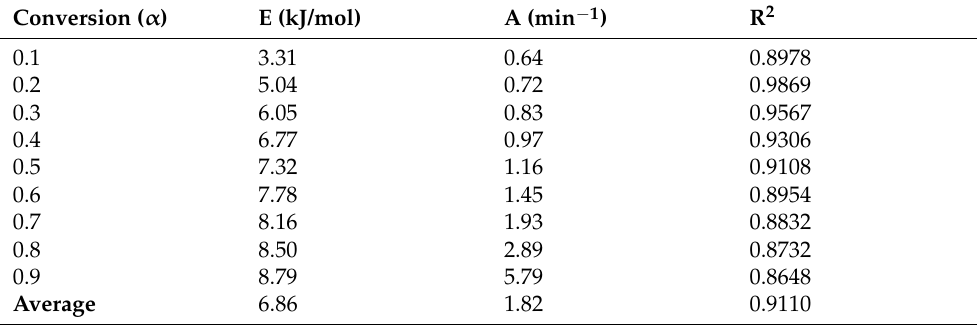
Figure 6. Linear plots of Coats-Redfern and Arrhenius kinetic models at different heating rates for PET MPs degradation. Table 4. Arrhenius and Coats-Redfern kinetic parameters of PET MPs degradation at different heat- Table 3. Computed kinetic parameters from the Friedman model. ing rates.